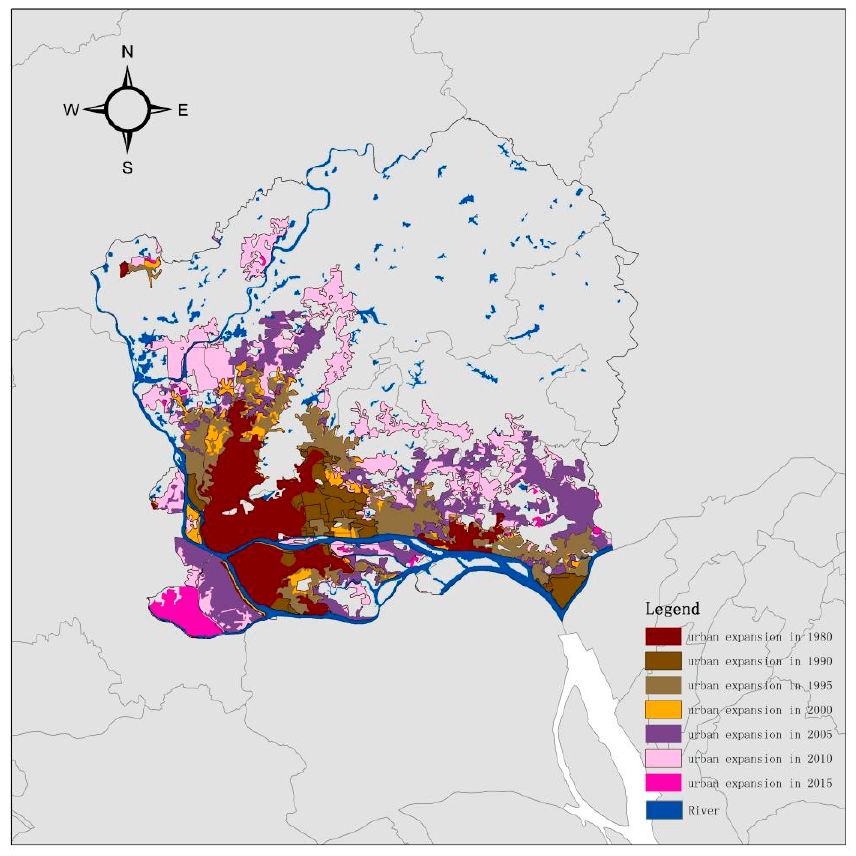
Figure 3. Urban expansion in Guangzhou in 1980, 1990, 1995, 2000, 2005, 2010, and 2015. (Source: drawn by the authors).